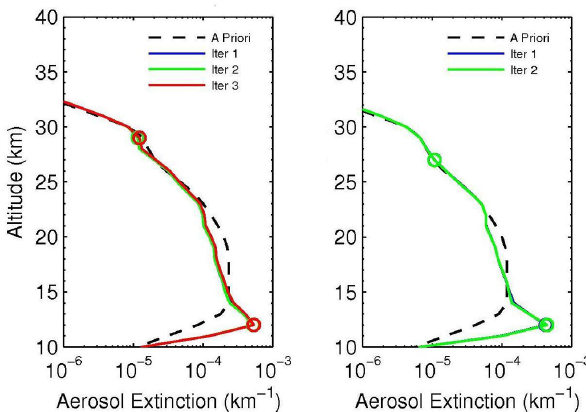
Fig. 10. The left panel shows the retrieved aerosol extinction pro- files for 750, 793, and 1028nm (color asterisk). Colored lines: 513- 682nm calculated aerosol extinction. Black lines: SAGE II pro- file at 525 and 1020nm. Dashed black line: interpolated SAGE II aerosol extinction profile at 750nm. The right panel shows the rel- ative difference (percent) between the retrieved aerosol extinction profiles and the ones from SAGE II.